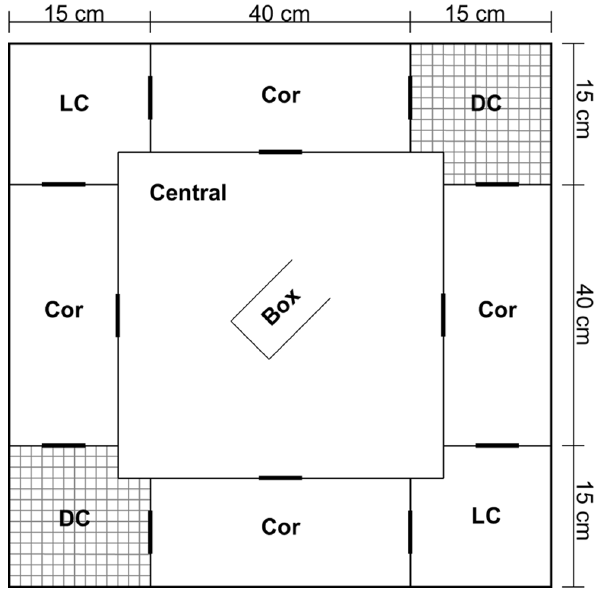
Figure 1. Concentric square field cage to test exploratory behaviour. CC=Covered Corners; Cor=Corridors; UC=Uncovered Corners; Central=Central Compartment; Box=dark box in which mice were transferred to the experimental cage. The holes, drawn in bold in the figure, that connect corridors with corners are 10 cm above the ground whereas the holes that connect the central area with the corridors are 1.5 cm above the ground.